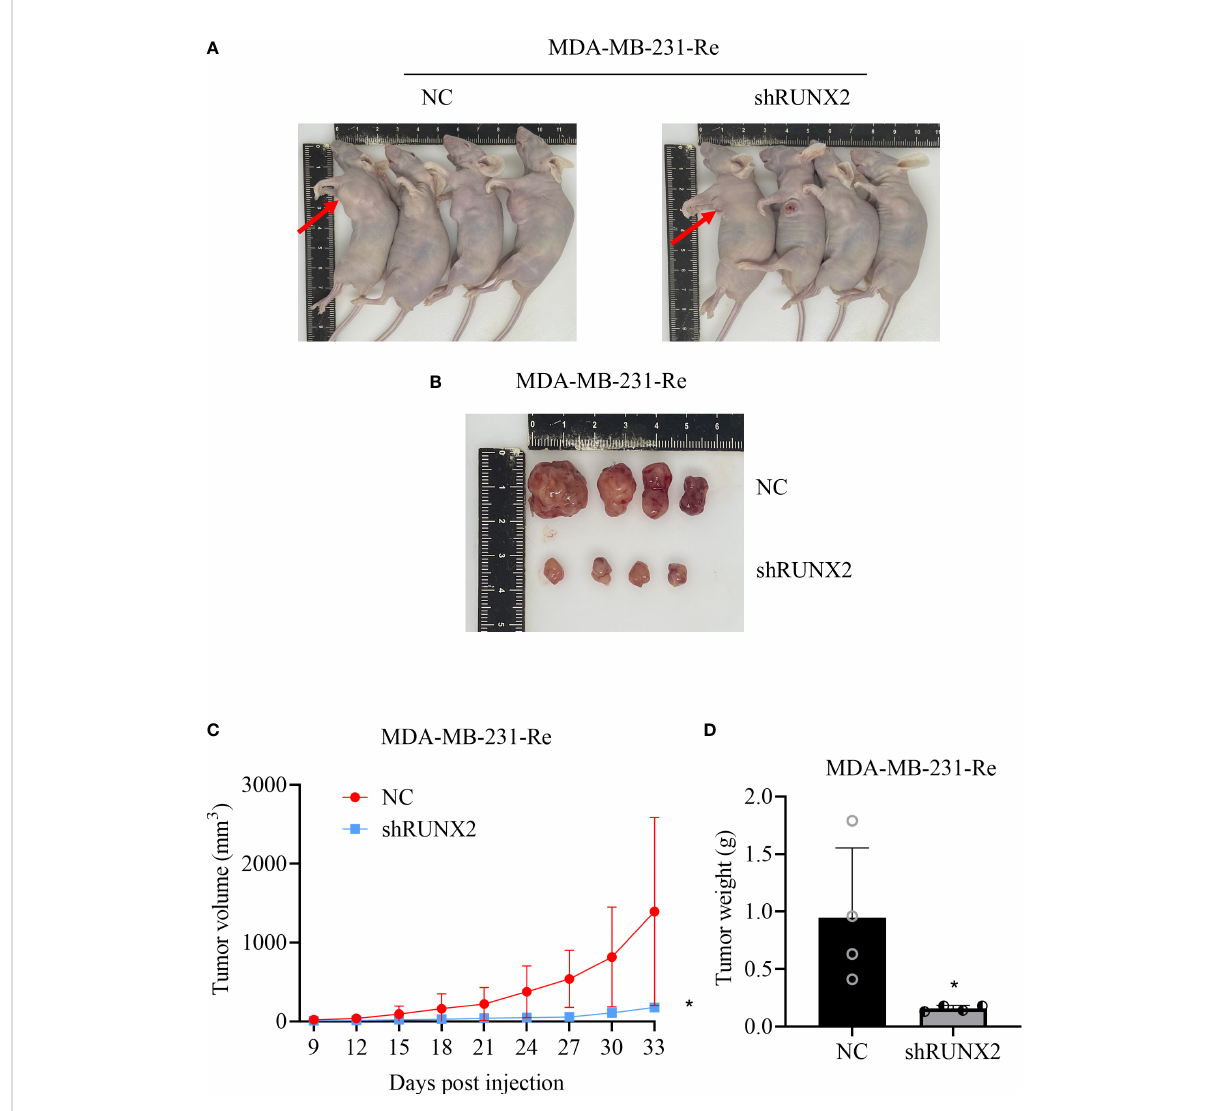
FIGURE 4 RUNX2 promoted the progression of breast cancer cells in vivo . (A) Image of in vivo subcutaneous neoplasia in BALB/c nude mice formed by the transplanted shRUNX2 and NC MDA-MB-231-Re cells. (B) Image of the tumor nodules formed by the transplanted shRUNX2 and NC MDA- MB-231-Re cells. (C) Tumor volume was measured in each group on the indicated days. (D) Tumors were removed after the last measurement on the 33rd day and weighed. All data were shown as mean ± SD (N=3 independent experiments).